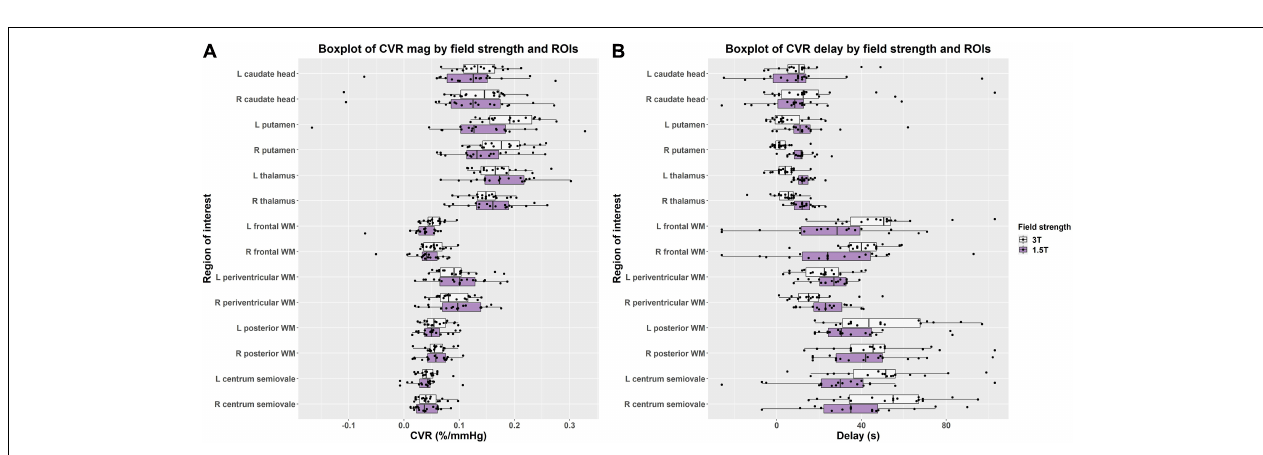
FIGURE 3 | Box (A,C) and scatterplots (B,D) of mean cerebrovascular reactivity (CVR) magnitude and delay values in subcortical gray and white matter at 1.5 and 3T. Lines of best fit for the subcortical gray/white matter CVR magnitude and delay are shown separately in pink/blue. (B = effect size, CI = confidence interval, p -values uncorrected for multiple comparisons).